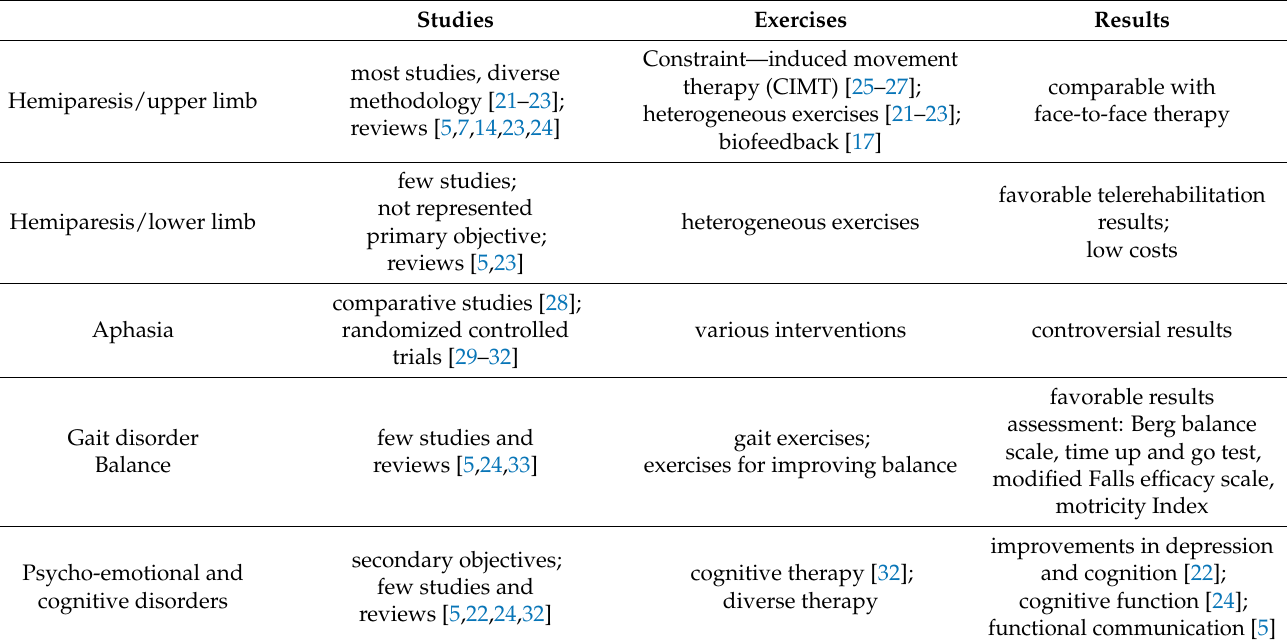
Table 1. Patients with various disabilities who can benefit from